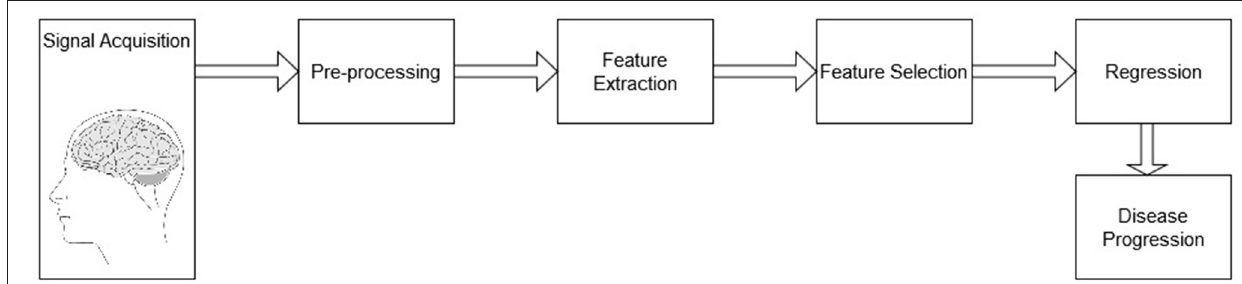
FIGURE 1 | Block diagram of the processing pipeline for AD severity level prediction.